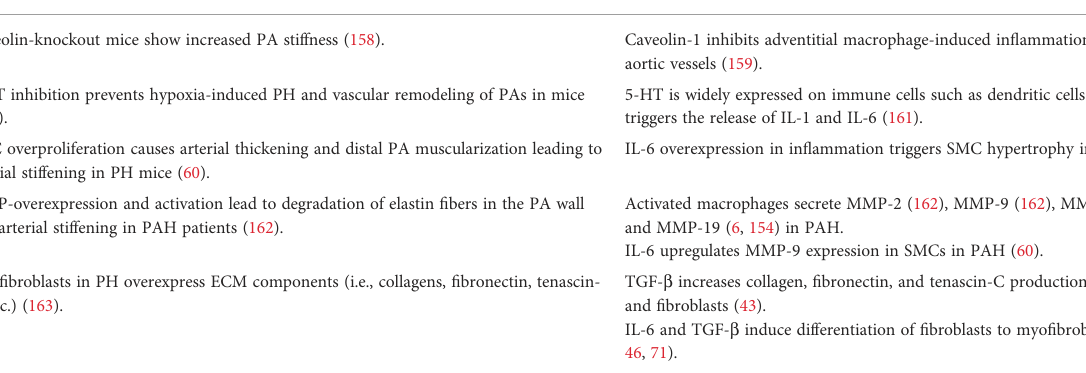
TABLE 2 Potential links between factors associated with PA stiffening and immune responses in PH. Factors associated with PA stiffening Potential link to immune responses in PH Caveolin-knockout mice show increased PA stiffness